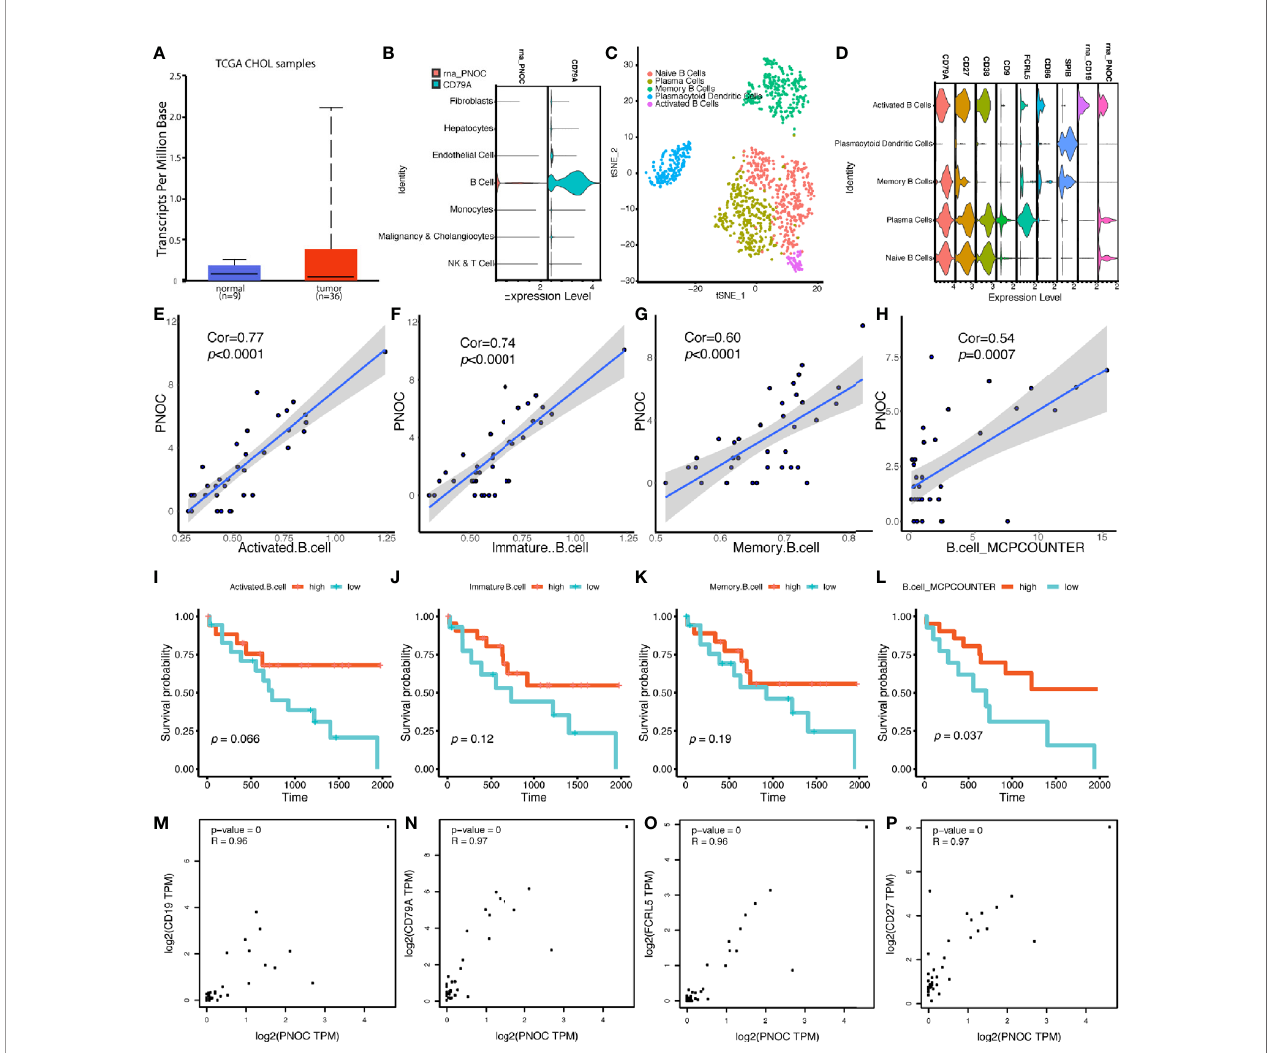
FIGURE 5 | PNOC Was Highly Expressed by B Cell Populations in CCA, and B Cell In fi ltration Levels in CCA Indicated Better Overall Survival. (A) PNOC was highly expressed in CCA tumors in TCGA database, though signi fi cant difference was not achieved. (B) PNOC was mainly expressed by B cells in single cell levels. (C) Further cluster of B cell populations. (D) Markers for sub B cell populations. (E – H) Correlation between PNOC expression and scores for activated CD8+ T cell, immature B cell, memory B cell, and whole B cell calculated by ssGSEA and MCPcounter methods. (I – L) B cell in fi ltration levels for activated CD8+ T cell, immature B cell, memory B cell, and whole B cell calculated by ssGSEA and MCPcounter methods were correlated with CCA patients ’ overall survival. (M – P) Correlation between CD19, CD79A, FCRL5, CD27, and PNOC in CHOL bulk sequencing samples from GEPIA